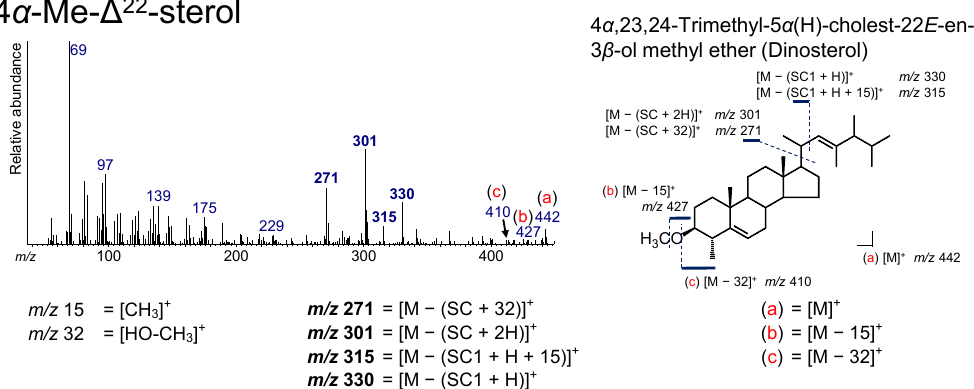
Figure 11. Electron ionization mass spectrum of 4 α ,23,24-trimethyl-5 α (H)- cholest-22 E -en-3 β -ol methyl ether (dinosterol). Bold numbers indicate an ion that accompanies the cleavage of the side chain. ( a )–( c ) Ions that are not accompanied by the loss of the side